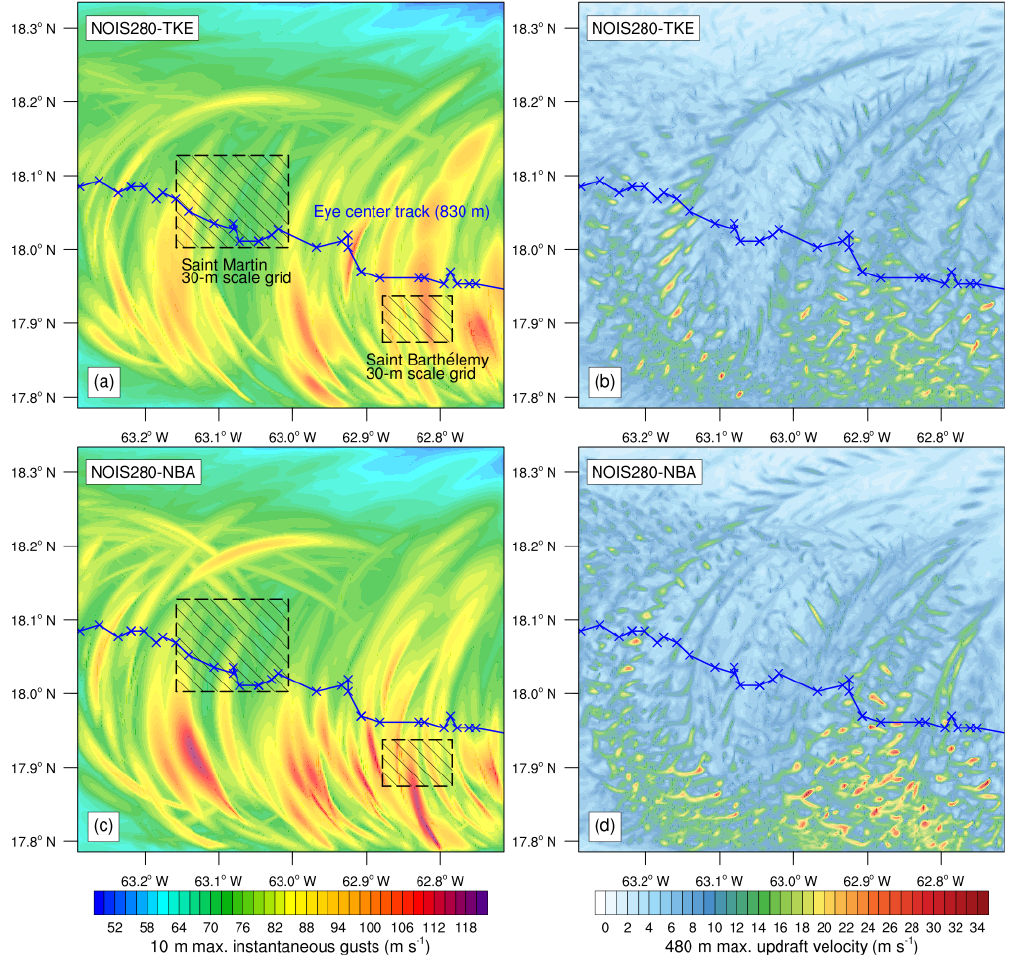
Figure 4. Comparison between the TKE SFS scheme and the NBA SFS scheme at 280m scale: non-island experiment NOIS280. (a, c) Max- imum instantaneous gusts (ms − 1 ) occurring at 10m during the 6h of simulation (history output interval of 1min). (b, d) Maximum updraft velocity (ms − 1 ) occurring at 480m during the 6h of